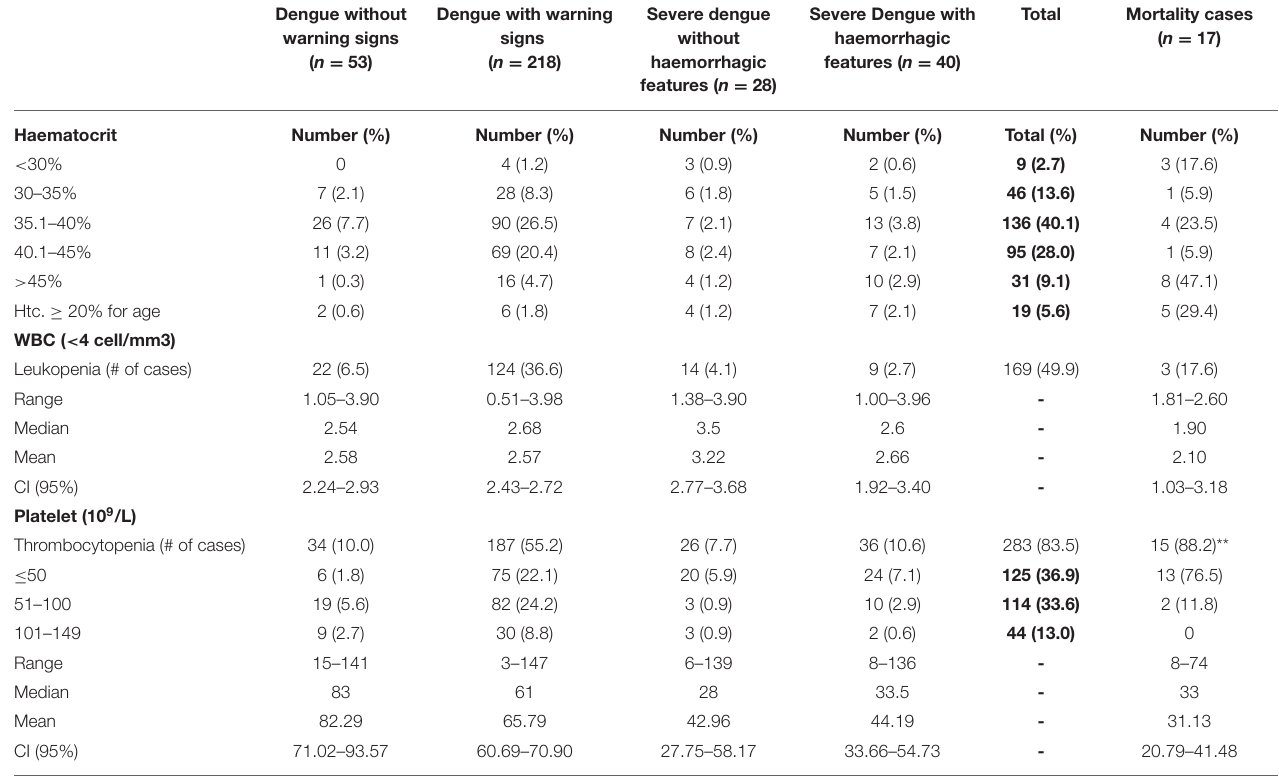
TABLE 5A | Laboratory investigations in pediatric patients hospitalized with suspected and confirmed dengue in the 2018–2019